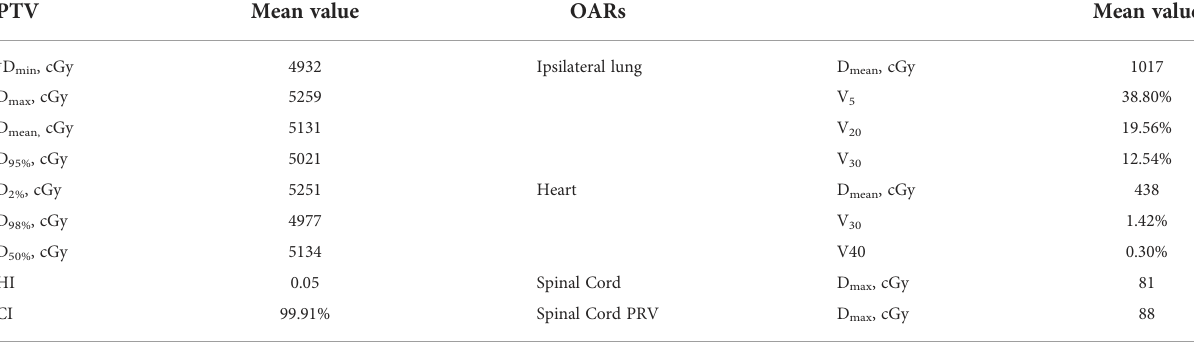
TABLE 1 Dosimetry evaluation of anthropomorphic phantom with 3D-printed bolus